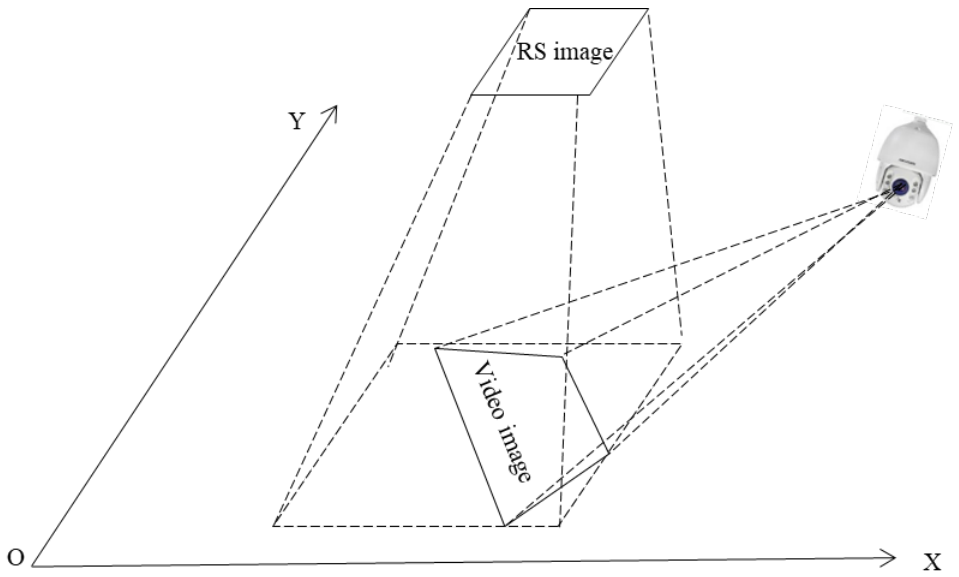
Figure 2. Di ff erent views of surveillance video and remote sensing sensors when capturing the same scene.